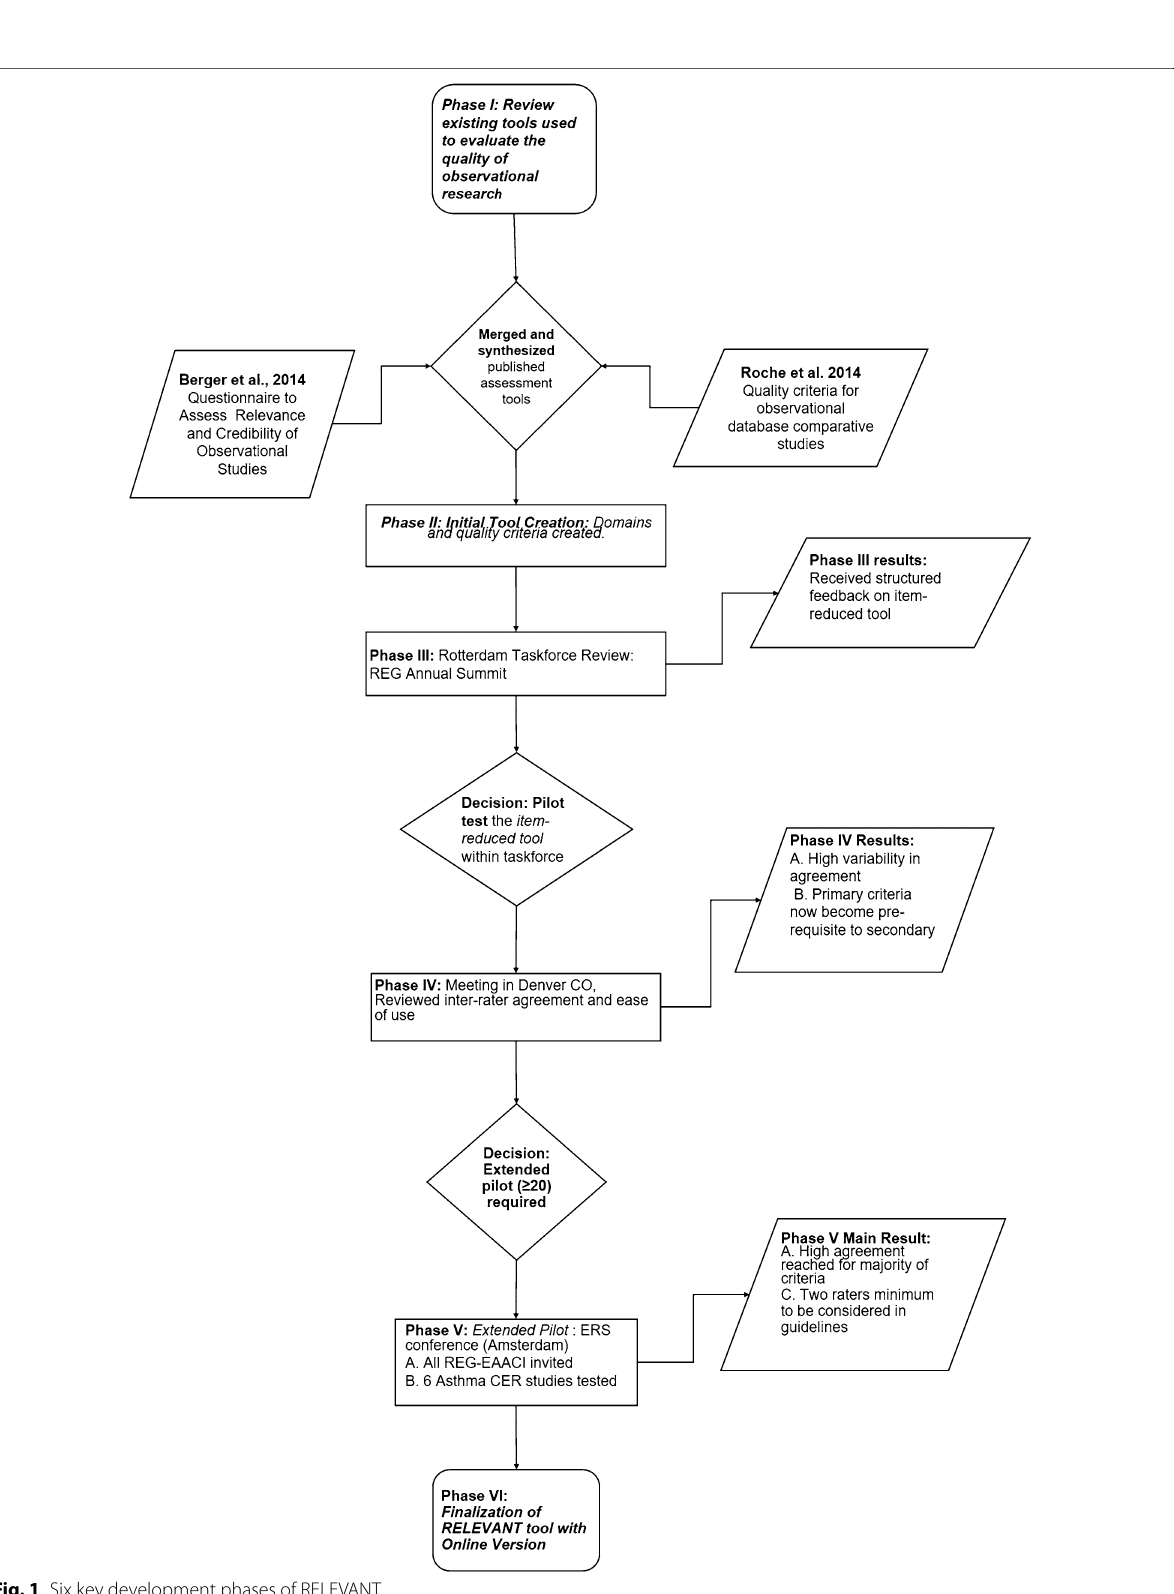
Fig. 1 Six key development phases of